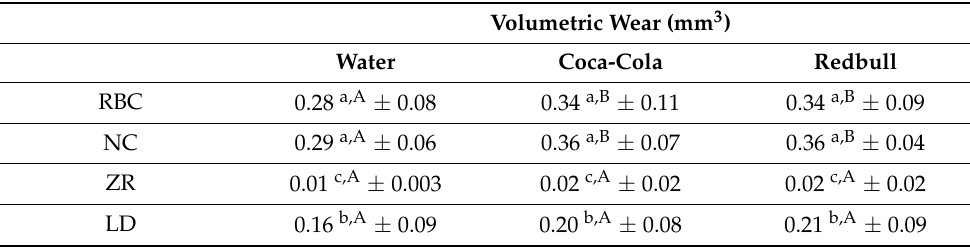
Table 2. Volumetric wear, expressed as mean ± standard deviation for all the tested subgroups. Same superscript capital letters indicate no difference between row results. Same superscript lower-case letters indicate no difference between column results.